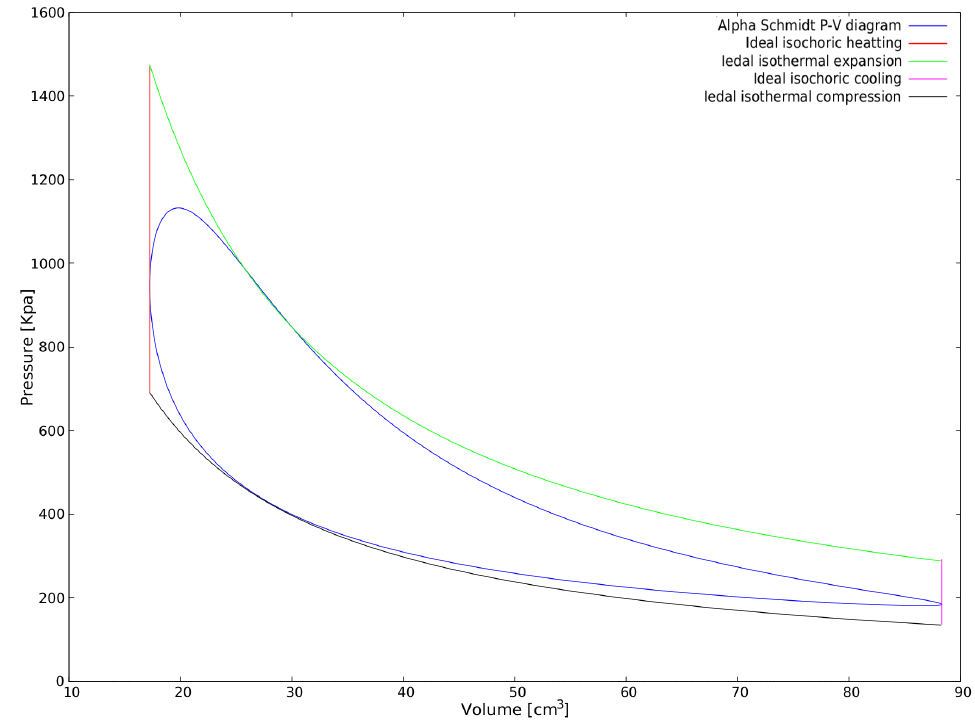
Figure 11. Alpha with crank drive P-V diagrams.